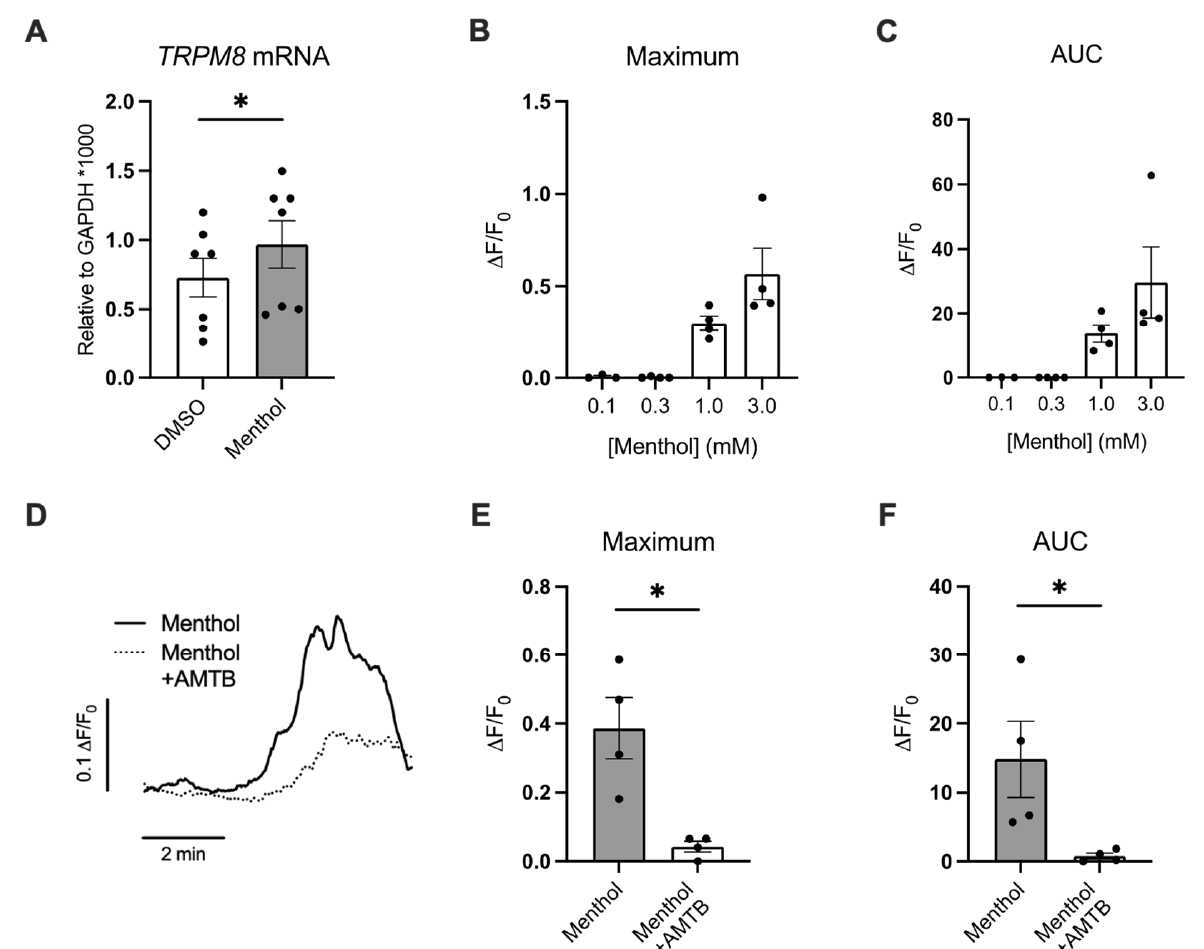
Figure 1. Menthol induces a Ca 2+ response in primary HBEC via TRPM8. ( A ) Expression levels of TRPM8 mRNA analyzed by ddPCR in HBEC treated with basolateral DMSO (0.1%) or menthol (1 mM) for 24 h. ( B,C ) Maximum ( B ) and area under the curve (AUC) ( C ) fluorescence changes caused by menthol (0.1, 0.3, 1.0, and 3.0 mM) in GCaMP6s-expressing HBEC. n ≥ 3, ≥ 2 lungs. ( D ) Representative tracing of GCaMP6s emission over time in HBEC exposed to menthol ± AMTB. ( E , F ) Maximum Ca 2+ response ( E ) and AUC ( F ) fluorescence changes caused by menthol (1 mM) ± AMTB (30 µ M). n = 4, 2 lungs. Statistics: Data shown as mean ± SEM. * p < 0.05, paired ( A ) or unpaired ( E , F ) t -test after assessing normality with Shapiro–Wilk.